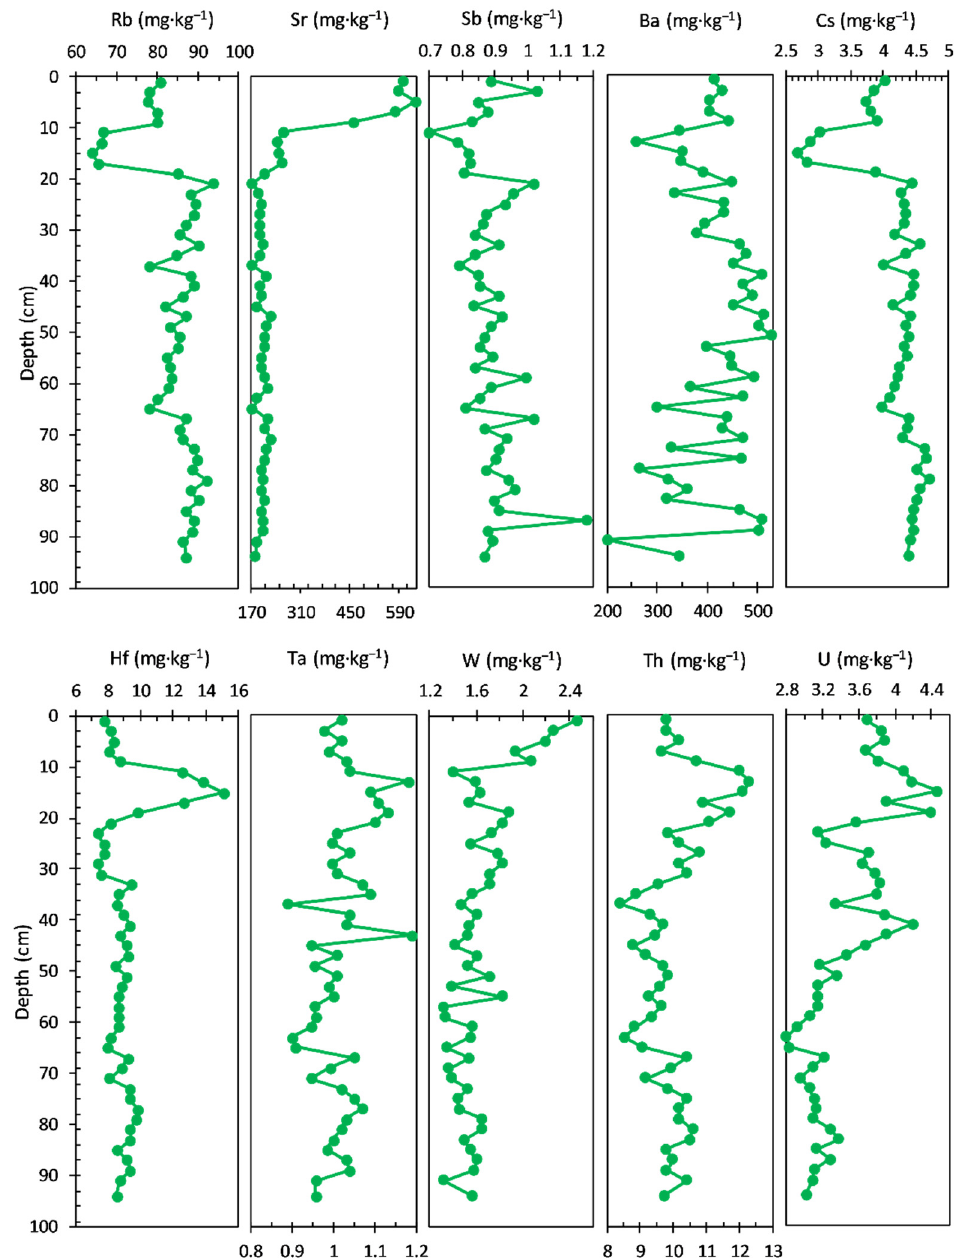
Figure 5. Vertical distribution of geochemical trace elements (Rb, Sr, Sb, Ba, Cs, Hf, Ta, W, Th, U) in the Lake Amara sediment core (94 cm depth).